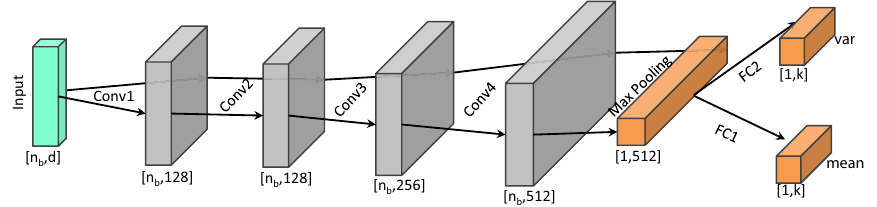
Fig. 2 Schematic visualization of the use encoder architecture used here, build from input given into 4 Convolutions, channel‑wise max pooling and two fully connected networks with three layers each (layers: 512, 256, k). The dimension after every operation is given in